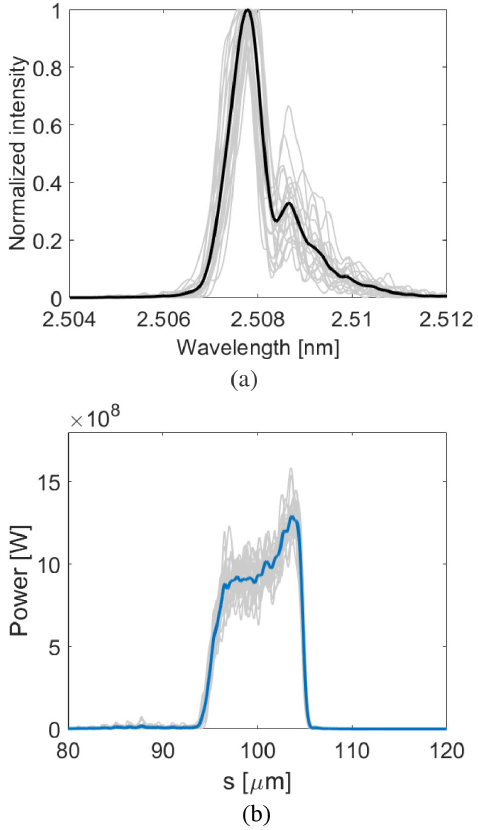
FIG. 7. (a) Output spectrum profiles at the end of the radiator (gray lines represent the 38th – 70th passes, and the black line represents the average spectrum over the 38th – 70th passes). (b) Output power profiles at the end of the radiator (gray lines represent the 38th – 70th passes, and the blue line represents the average power over the 38th – 70th passes).